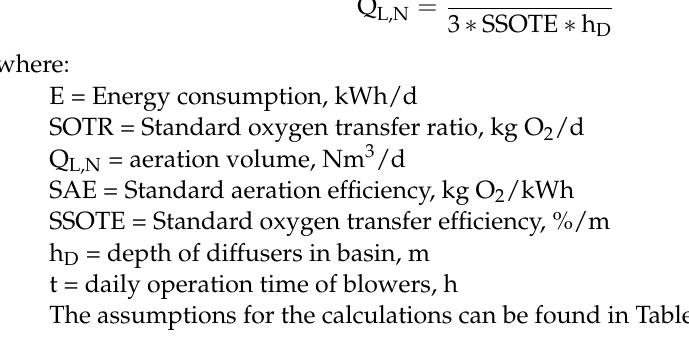
Table 3. Assumptions for the calculation of aeration energy consumption of the scenarios based on the airflow generated in SIMBA. Parameter Value